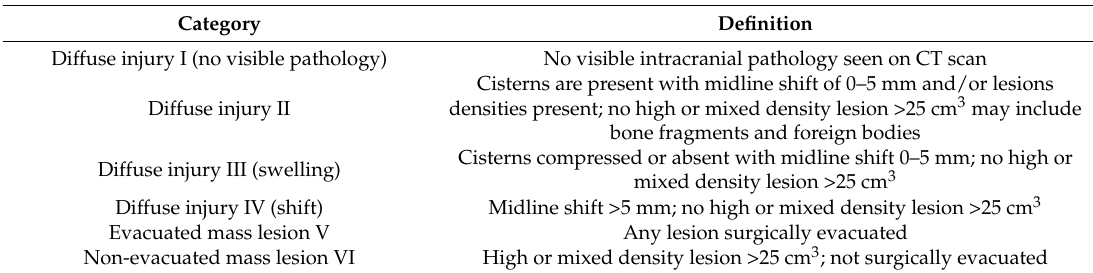
Table 2. Marshall CT score of traumatic brain injury.